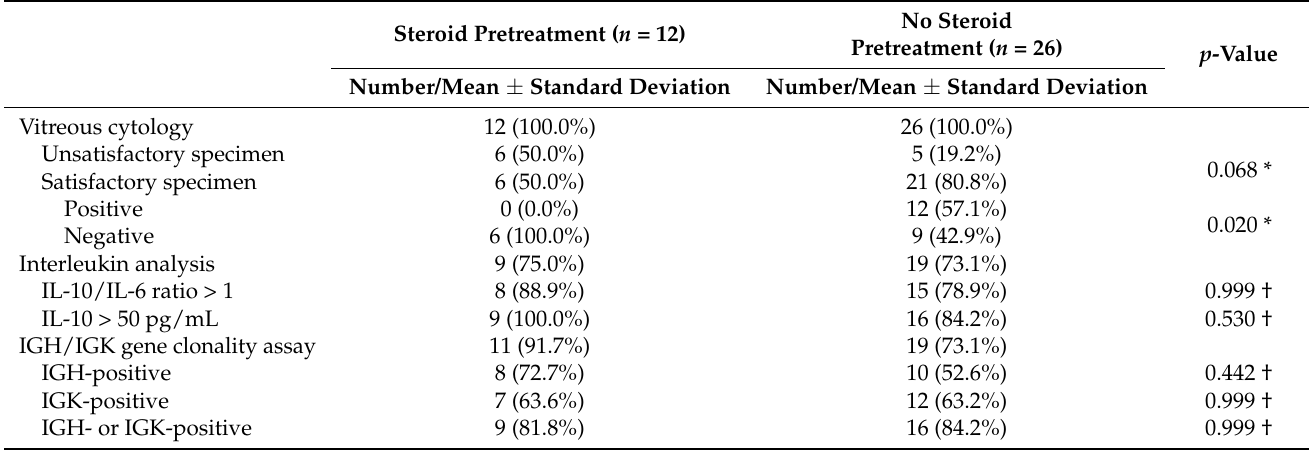
Table 5. Effect of steroid pretreatment on the diagnostic tests for vitreoretinal